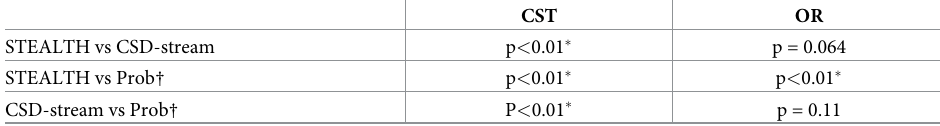
Table 2. Statistical comparison between methods for the 32 dir acquisition data only.